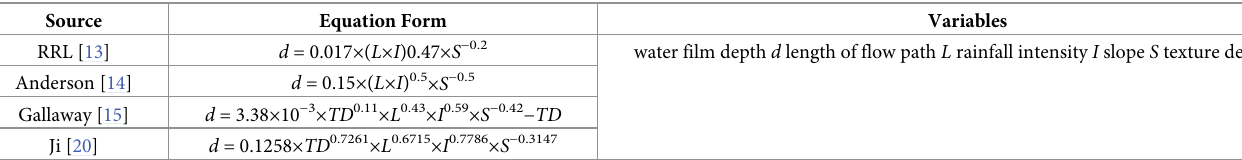
Table 2. Water film depth prediction